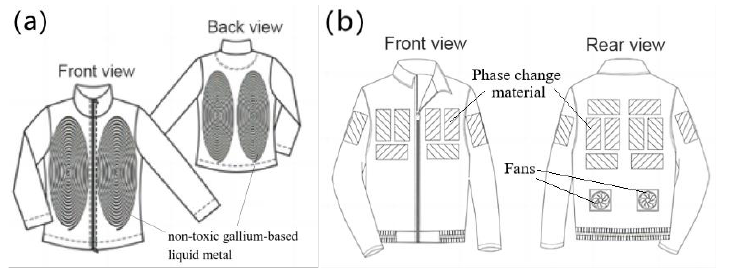
Figure 3. Clothing with integrated refrigeration components. ( a ) Liquid metal − based active cooling